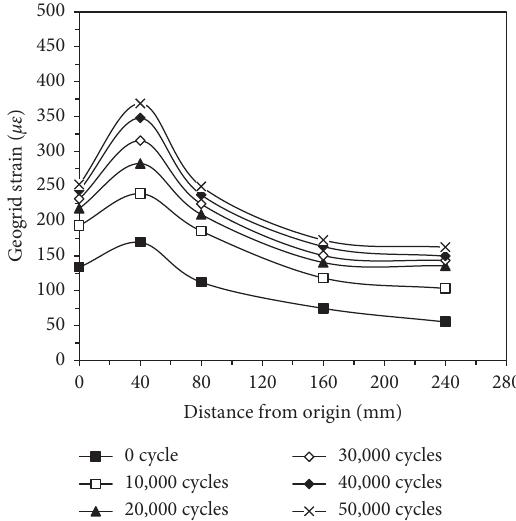
Figure 11: Geogrid strain distribution curves of the geogrid in RGF1 under cyclic loading.